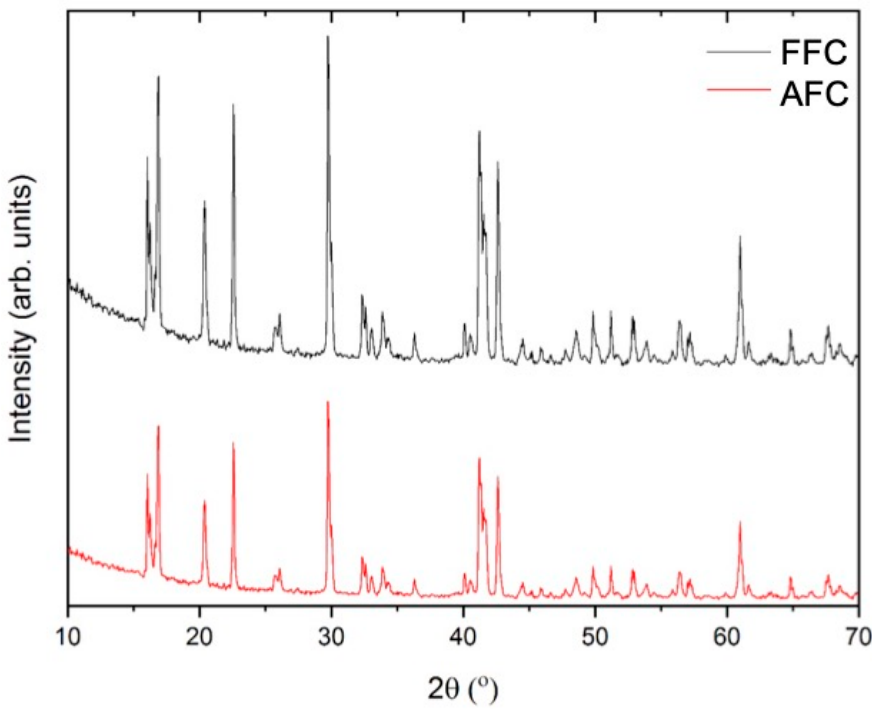
Figure 3. XRD patterns of the obtained ferrous chloride samples.